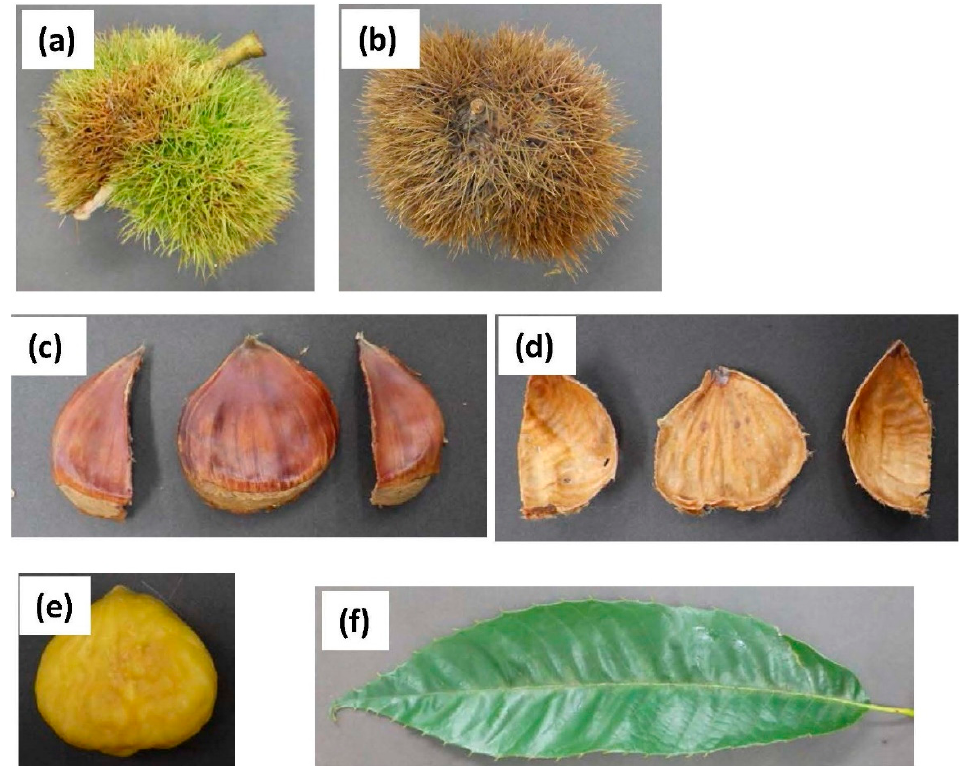
Figure 1. Photographs of Japanese chestnut ‘Porotan’ components. ( a ): Burs (green), ( b ): burs (brown), ( c ): shells, ( d ): inner skin, ( e ): kernel, ( f ): leaf.